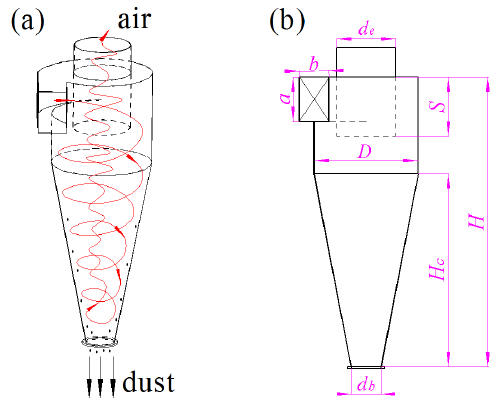
Figure 1. Diagrams of peanut whole-feed combine with a dust suppression device: ( a ) side view; ( b ) rear view.